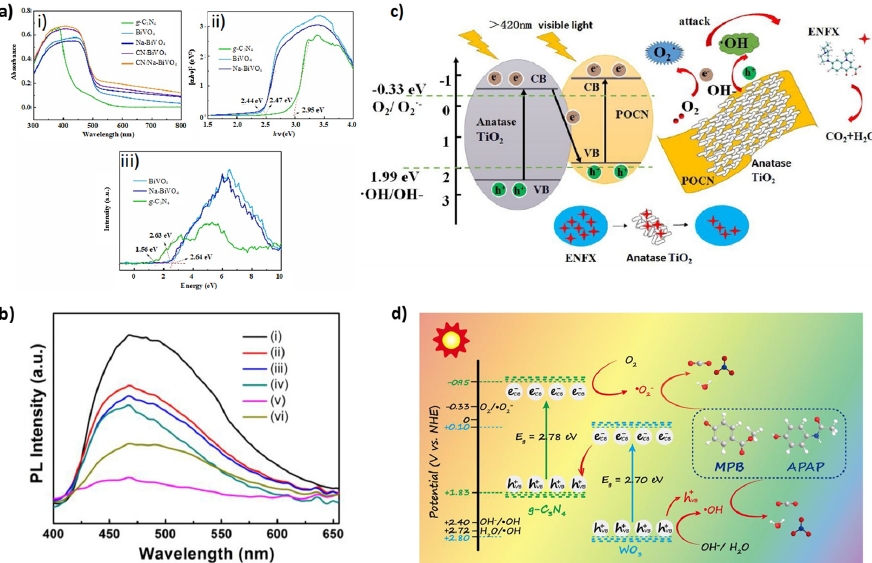
Figure 9. ( a ) UV–vis DRS spectra (i) and Mott–Schottky plots (ii) of catalysts, XPS valence spectra (iii) of g -C 3 N 4 , BiVO 4 , and Na-BiVO 4 . Reproduced from [130]. Copyright 2021, Elsevier. ( b ) Photolu-